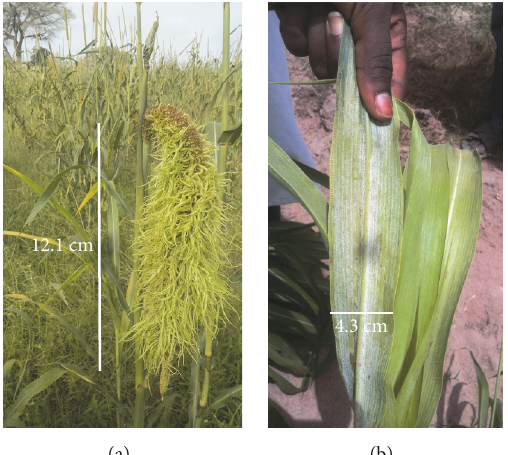
Figure 5: Typical downy mildew symptoms: panicle malformation (a) and abaxial sporulation on leaf (b) observed during on-farm downy mildew survey.